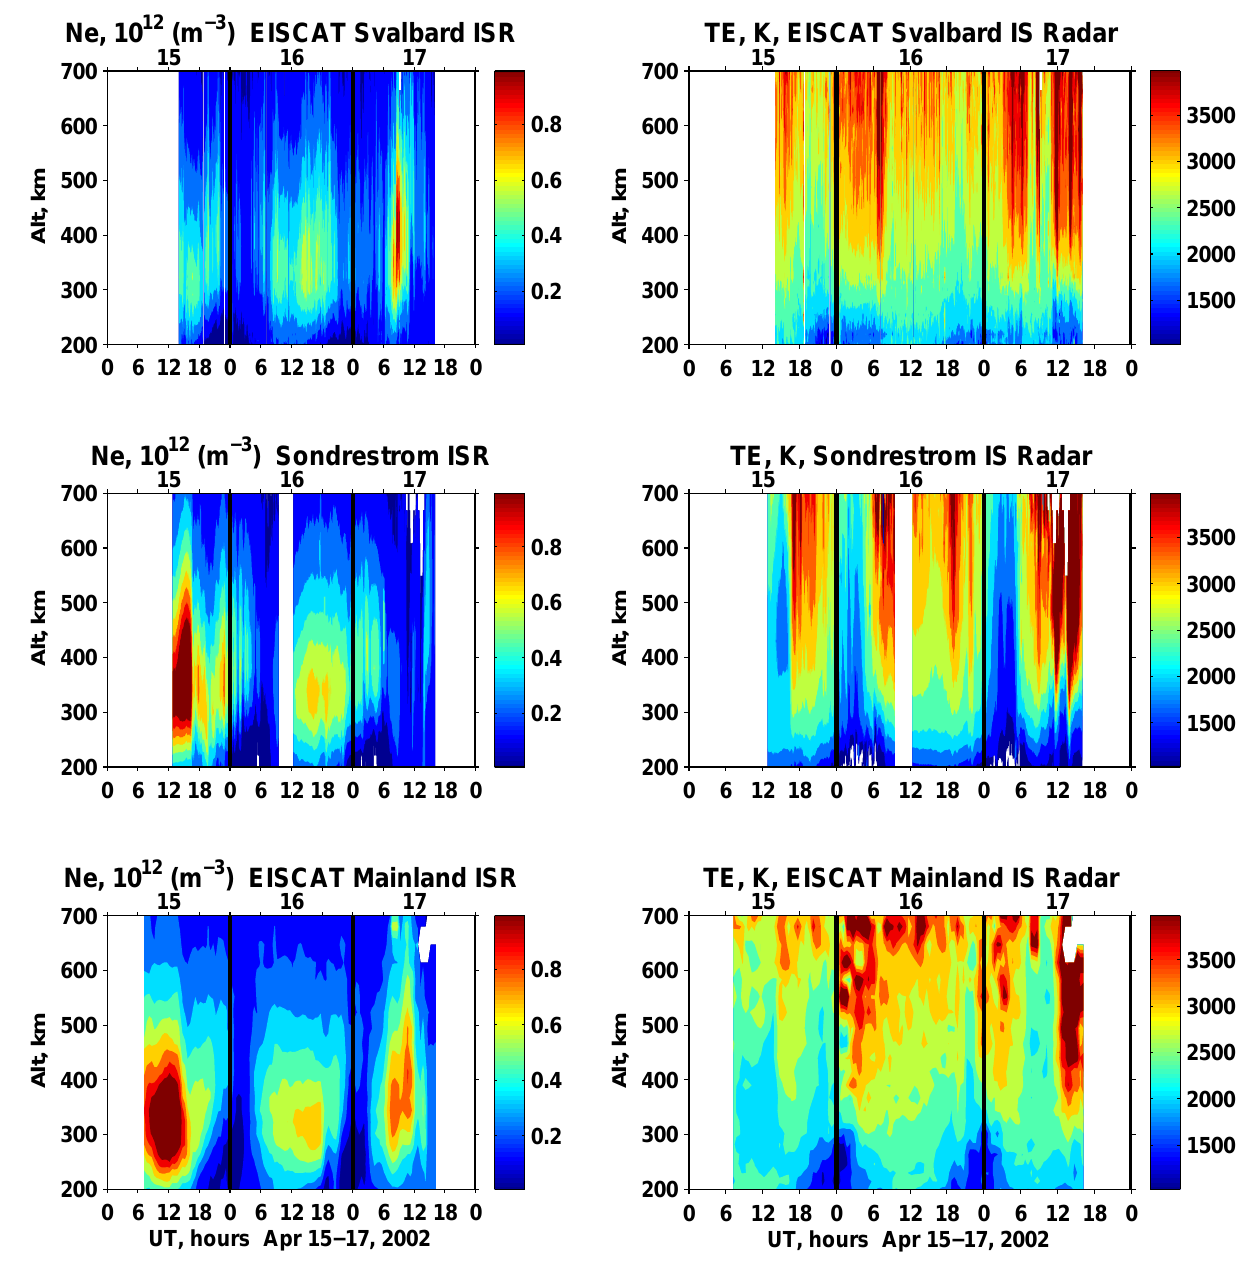
Fig. 3. Variations in the electron density (left panel) and electron temperature (right panel) on 15–17 April 2002 at high-latitude locations EISCAT Svalbard (top), Sondrestrom (middle), and EISCAT mainland